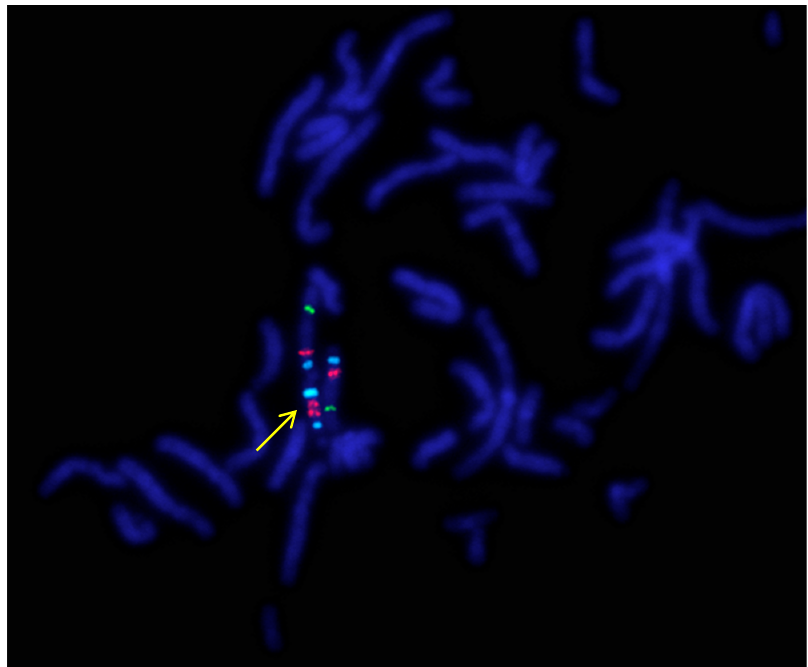
Figure 1. A representative metaphase fluorescence in situ hybridization (FISH) result of P.1. using the Prader–Willi/Angelman Critical Region ( UBE3A ) probe (Vysis, Abbott) (1000× magnification). The arrow indicates the idic(15). Signals: Aqua/blue— D15Z1 , Orange/red— UBE3A locus, FITC / green— PML locus (15q24). Because of the signal positions, these probes show no di ff erence between the markers of the five